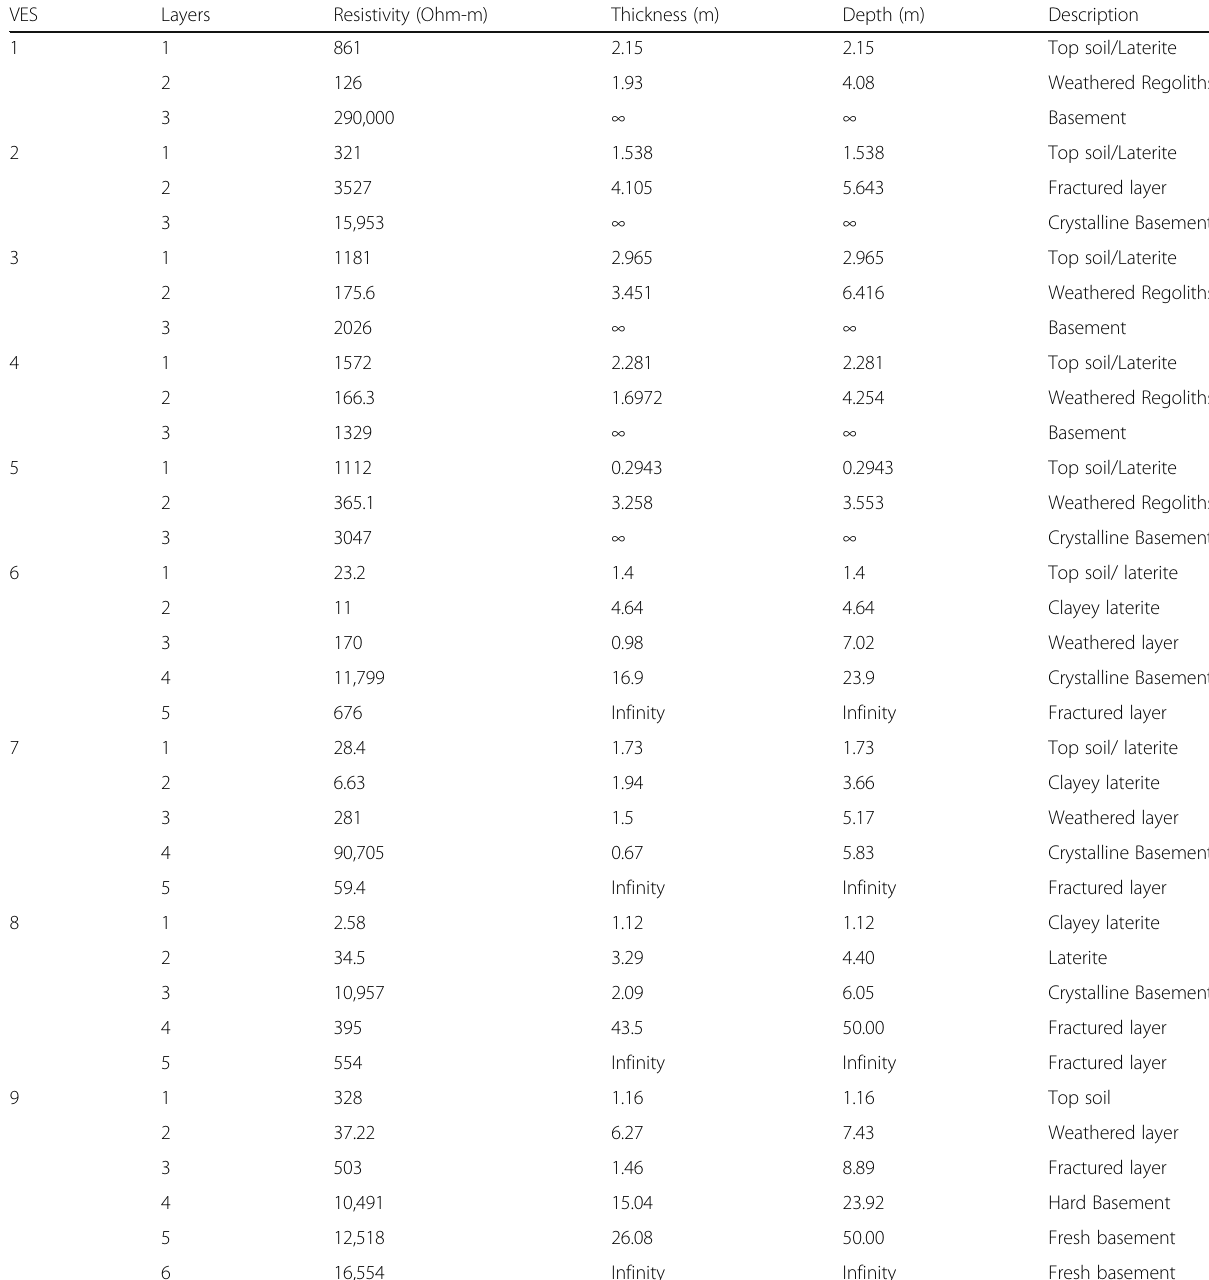
Table 5 Vertical Electrical Soundings (VES) of the different areas showing depth and thickness of soil layers VES Layers Resistivity (Ohm-m) Thickness (m) Depth (m)